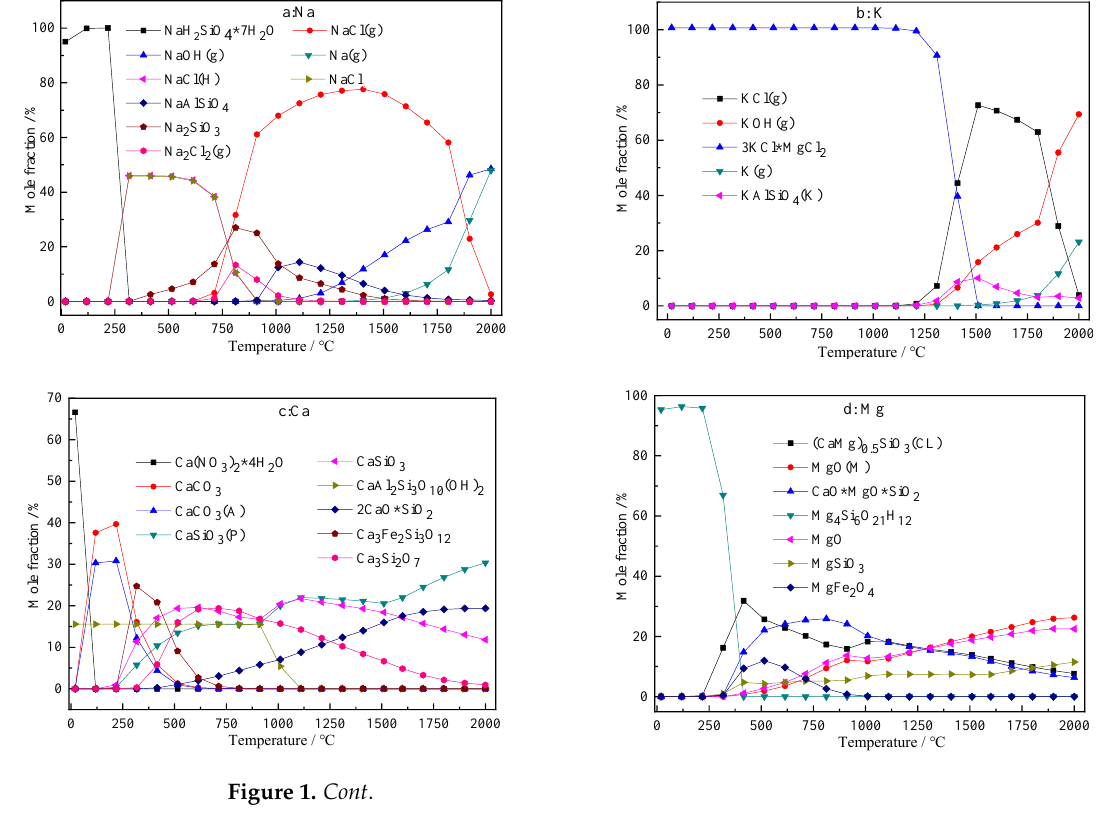
Figure 1. Effect of incineration temperature on the migration and transformation of the major ele- ments in ash. ( a ): Na, ( b ): K, ( c ): Ca, ( d ): Mg, ( e ): Cl, ( f ): Si. The asterisk in the chemical formula shows that the molecules or species are attached with each other as independent species, similarly hereinafter. 3.1.2. Effect of Al(NO 3 ) 3 Addition on the Migration and Transformation of Major Ele- ments in Ash by Using Thermodynamic Equilibrium Analysis It is evident that the addition of Al(NO 3 ) 3 exerts a significant effect on the migration and transformation of the main elements in ash. As shown in Figure 2a, when the amount of Al(NO 3 ) 3 addition increases from 0 to 0.1 kmol, the content of Na 2 SiO 3 decreases dras- tically. As the amount of Al(NO 3 ) 3 addition continues to increase, the content of gaseous NaCl gradually decreases, whereas the content of NaAlO 2 increases rapidly. The melting